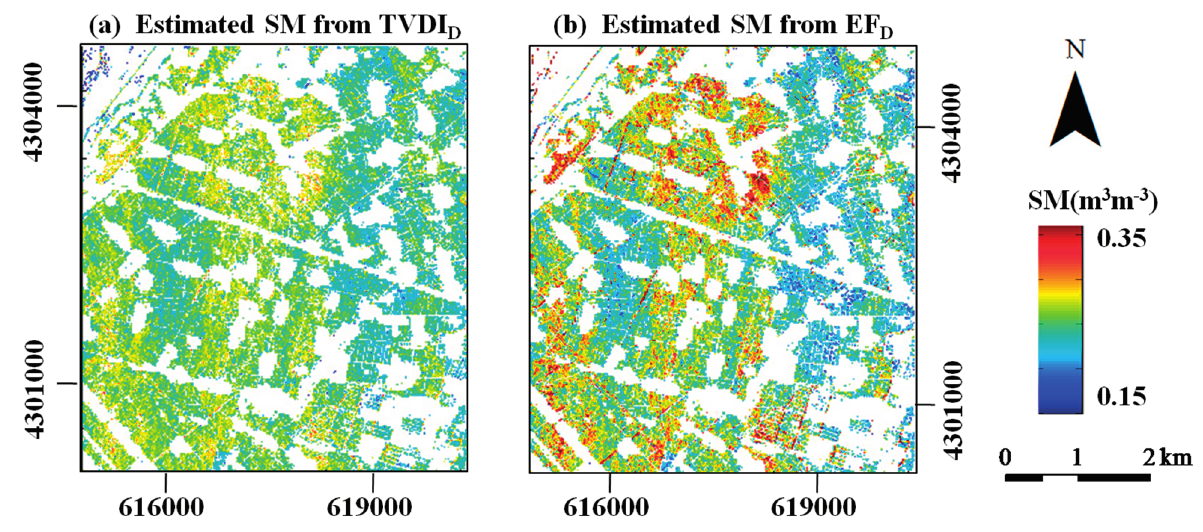
based on (cid:2888) space. /Fr (cid:2929) (cid:2888)